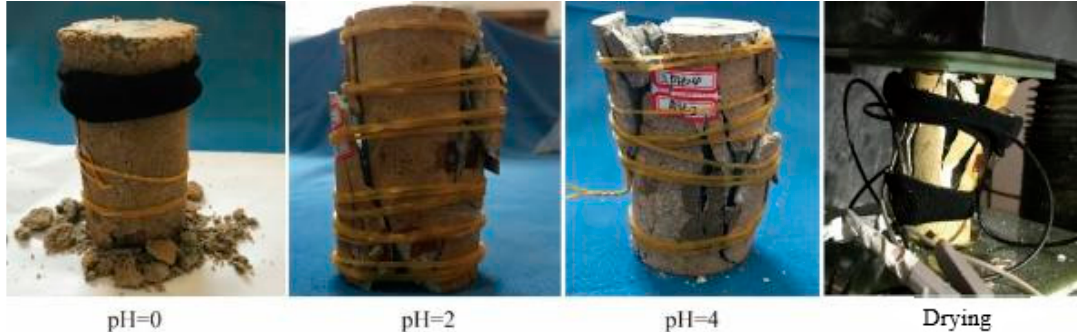
Figure 5. Failure features of lamprophyre.